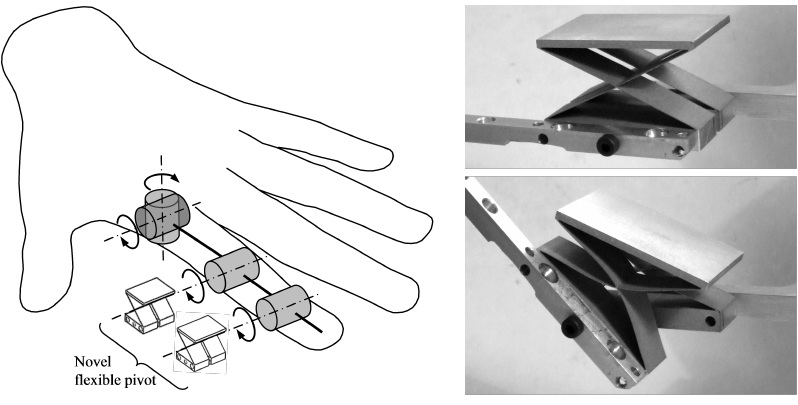
Figure 7. On the left: flexible pivot X 2 as an interphalangeal pivot joint for the finger design with multiple degrees of freedom. On the right: monolithic structure prototype X 2 obtained by aluminum electrical discharge machining ( S 9 mm × 7 mm × 5